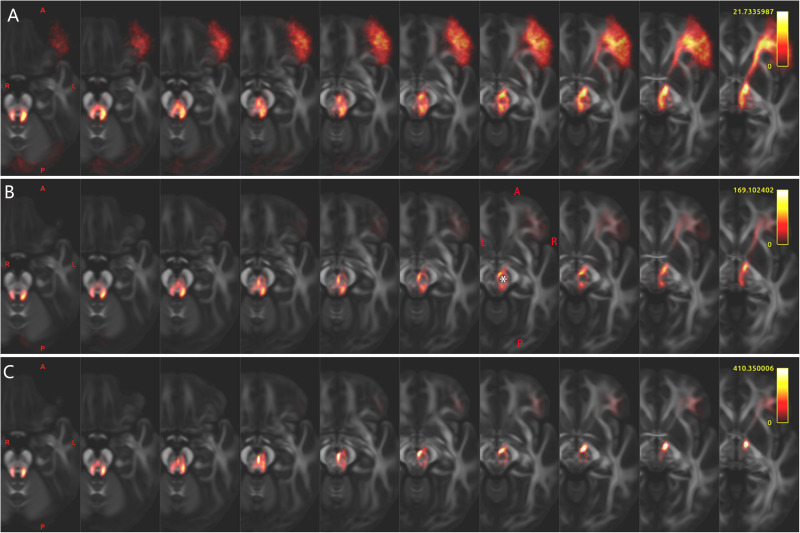
Multi-slice views of the pathway of Crus–Broca tracts that bypass the left red nucleus (RN). The pathways of Crus–Broca tracts from all subjects reconstructed via DSI Studio (A), FSL (B), and MRtrix3 (C) are consistent with one another. The decussating paths originating from the right Crus regions of interest (ROI)s merge with the non-decussating paths from the left Crus ROIs into one fasciculus, which bypasses the left RN (denoted by the white asterisk in the seventh image of B). The anatomical directionality of the multi-slice images from left to right for each panel is from inferior to superior.